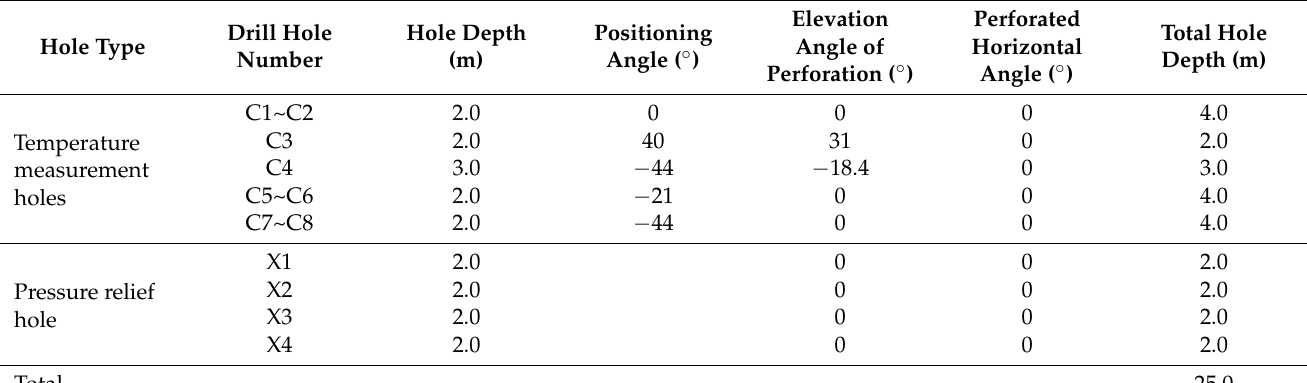
Table 1. Summary of depth and pitch (elevation) angle of temperature measurement and pressure relief